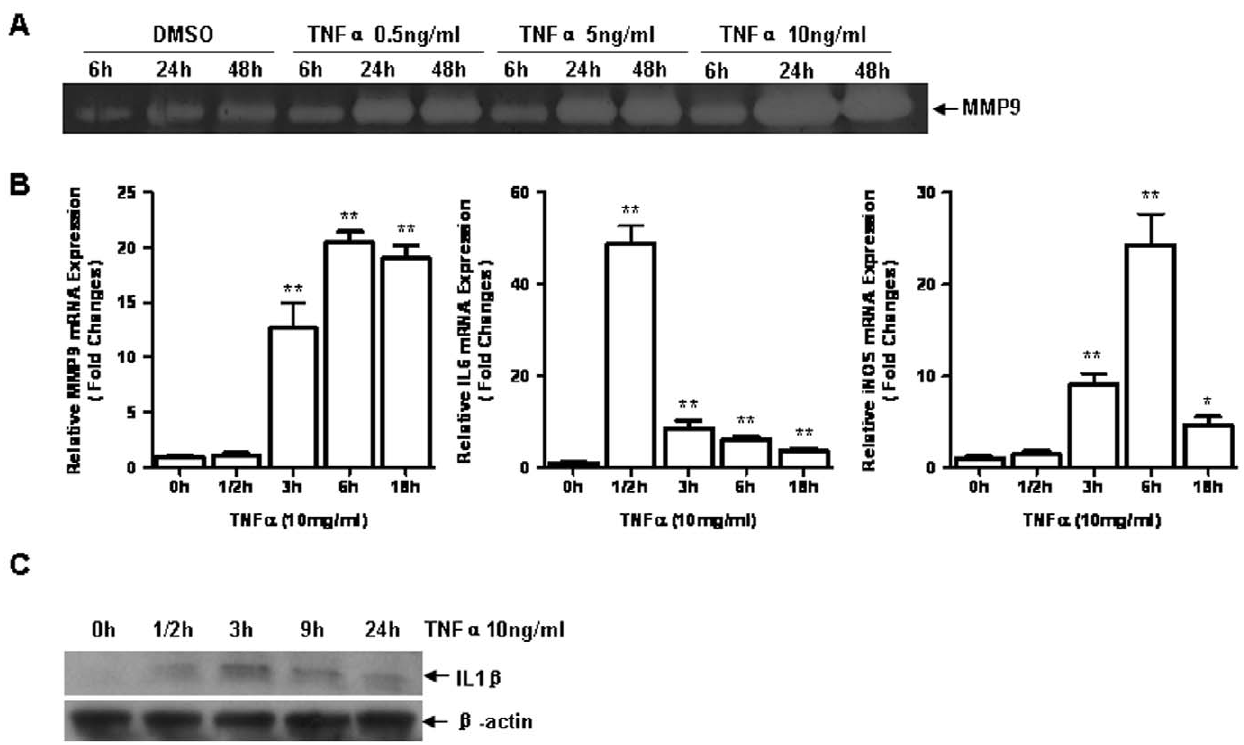
Figure 1. TNF- a induced overexpression of MMP-9, iNOS, IL-6 and IL-1 b in 3T3/NIH fibroblasts. A. 3T3/NIH cells were incubated for 6, 24 or 48 hours (h) with varying concentrations of TNF- a , gelatin zymography were performed to detect MMP-9 expression in the medium. B. Cells were treated by TNF- a (10 ng/ml) for 0, 1/2, 3, 6, 18 h, relative mRNA expressions of MMP-9, iNOS and IL-6 were examined by real-time RT-PCR analysis (n=3 per group, * p , 0.05 vs. 0 h; ** p , 0.01 vs. 0 h). C. Cells were treated by TNF- a for 0, 1/2, 3, 9, 24 h, IL-1 b was measured by western blotting